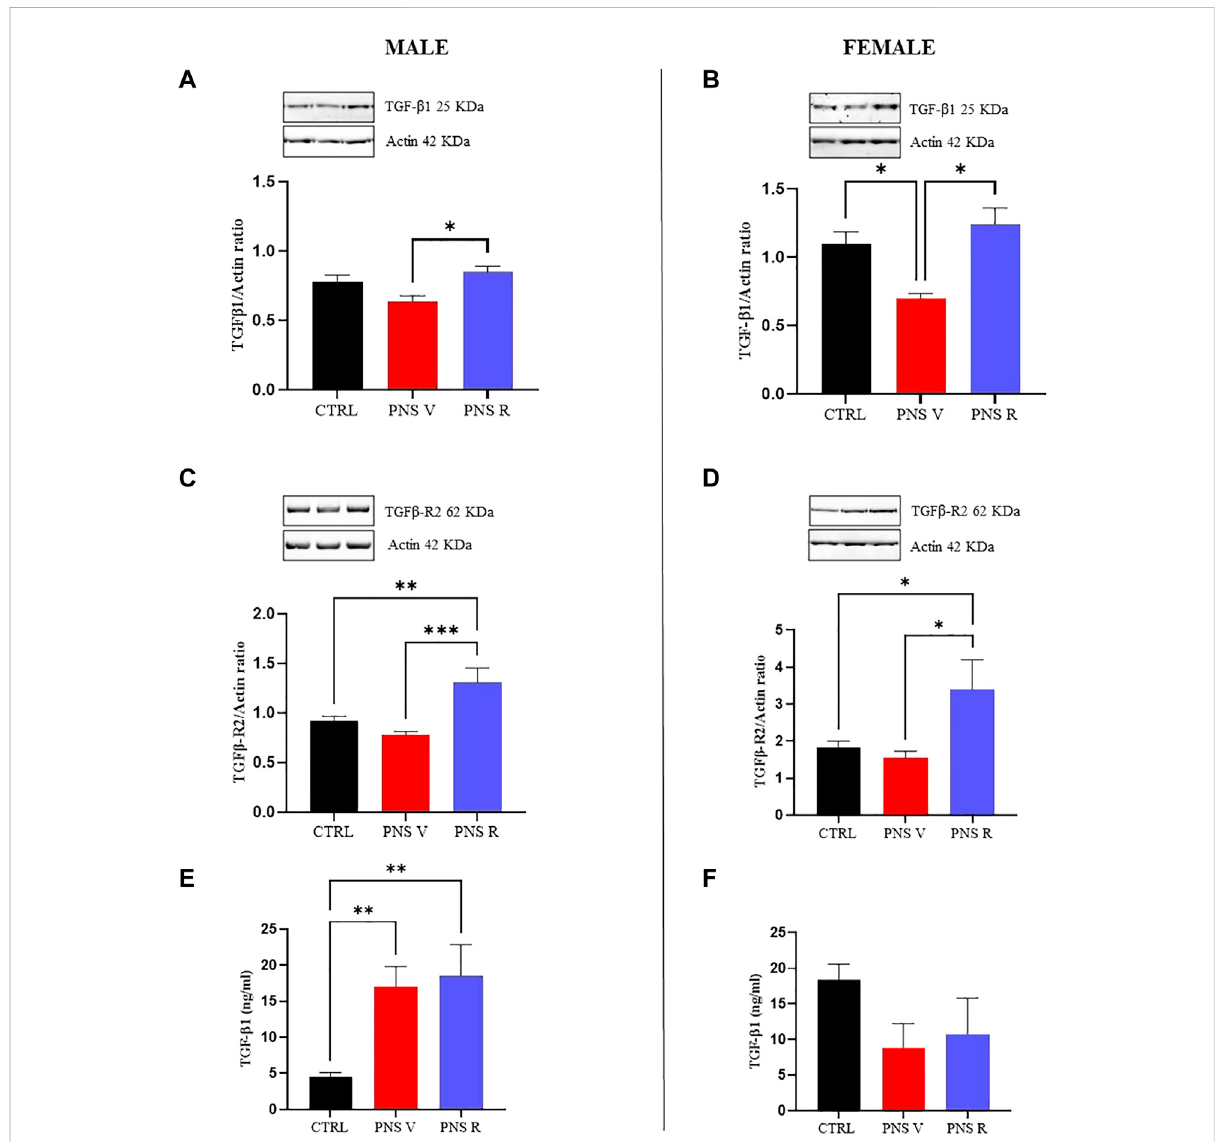
FIGURE 4 Role of TGF- β 1 pathway in the mechanisms of vulnerability and resilience to PNS exposure. Effects induced by PNS exposure on TGF- β 1 levels and of its receptor TGF β -R2 in total protein extracts from hippocampus of CTRL and PNS rats evaluated by Western Blot analysis. (A) Representative immunoblot and histogram of TGF- β 1 (44 kDa) in CTRL and PNS male adolescent rats (* p < 0.05 vs. PNS V). (B) Representative immunoblot and histogram ofTGF- β 1(44 kDa)inCTRLand PNSfemaleadolescent rats(* p < 0.05vs.CTRL;* p < 0.05 vs.PNS V). (C) Representative immunoblot and histogram of TGF β -R2 (65 kDa) in CTRL and PNS male adolescent rats (** p < 0.01 vs. CTRL; *** p < 0.001 vs. PNS V). (D) Representative immunoblotandhistogramofTGF β -R2(65 kDa)inCTRLandPNSfemaleadolescentrats(* p < 0.05vs.CTRL;* p < 0.05vs.PNSV).TGF- β 1andTGF β - R2 densitometric values were normalized against actin used as internal control. Plasmatic levels of TGF- β 1 (ng/ml) in male (E) (** p < 0.01 vs. CTRL) andfemale (F) .All dataare shownas mean±SEM ofCTRLmale n =10; PNSV male n = 9;PNS Rmale n =5;CTRLfemale n =10;PNS Vfemale n =5; PNS R female n =